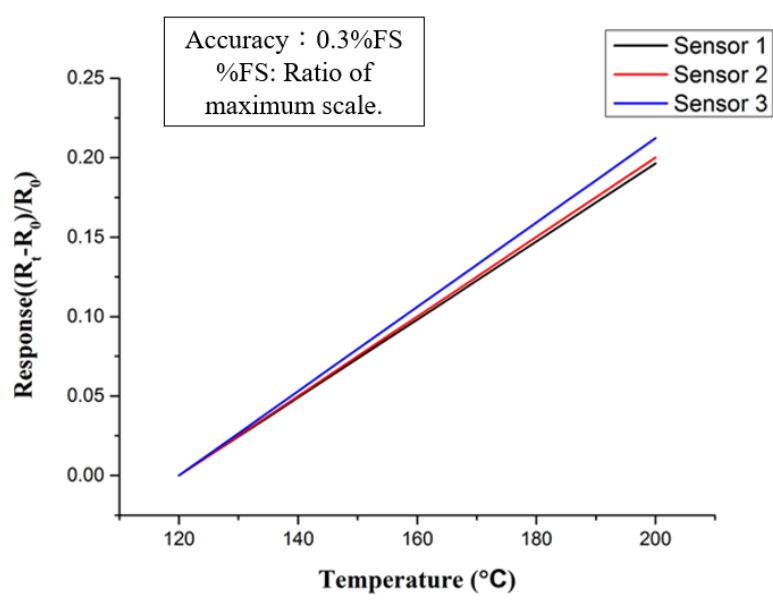
Figure 4. Dimensionless calibration curve of micro temperature sensor.